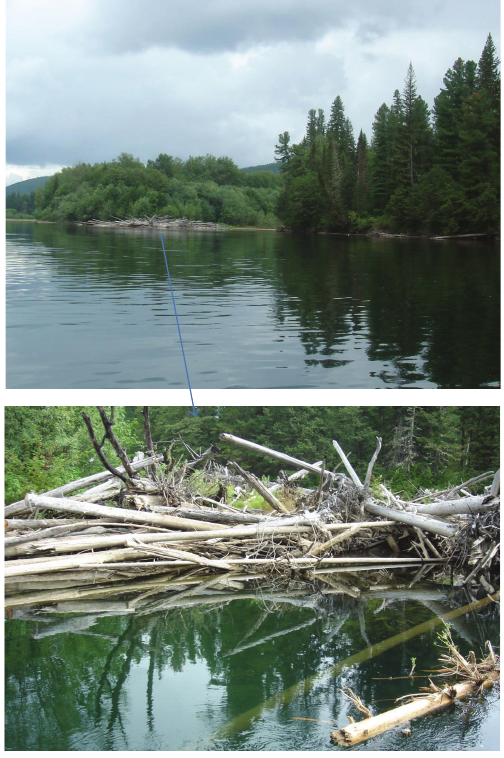
Figure 7: Numerous subsurface “log gorges” on the river, a habitat of